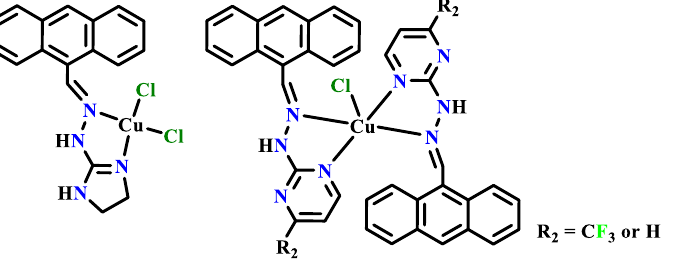
Figure 43. Copper(II) complexes of 9-anthrahydrazone with imidazoline or pyrimidine as the side chain. side